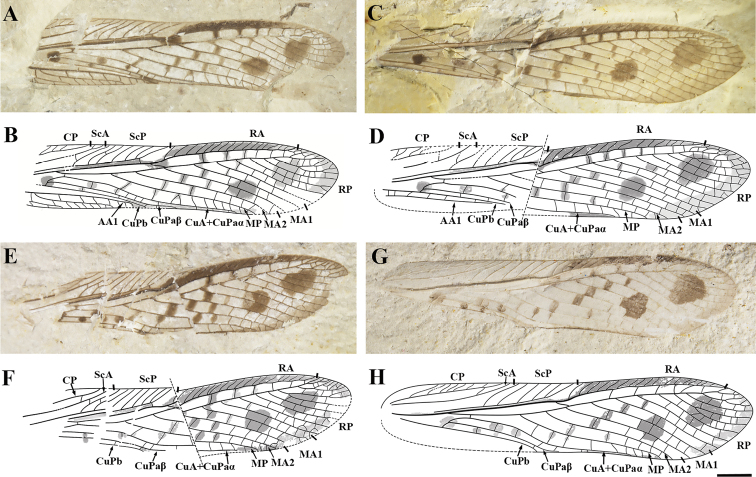
Photo and line drawing of Parelcana
pulchmacula sp. nov. A, B holotype, CNU-ORT-NN2016041 C, DCNU-ORT-NN2016035 E, FCNU-ORT-NN2016042 G, HCNU-ORT-NN2016036. The inclined and dotted lines in the middle of the wings of D and F represent the cracks in the specimen. The dotted line on the wing venation represents the imaginary line of the wing. Scale bar: 2 mm.